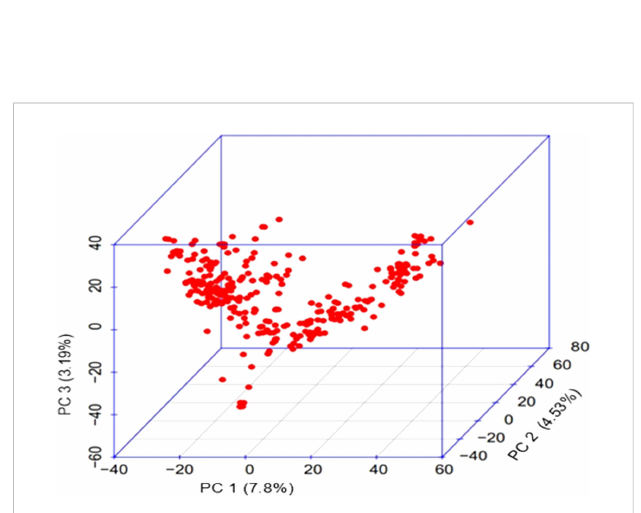
FIGURE 2 3D PC scatter plot (3D PC) for genotypes based on the fi rst three principal components (PC1, PC2 and PC3).